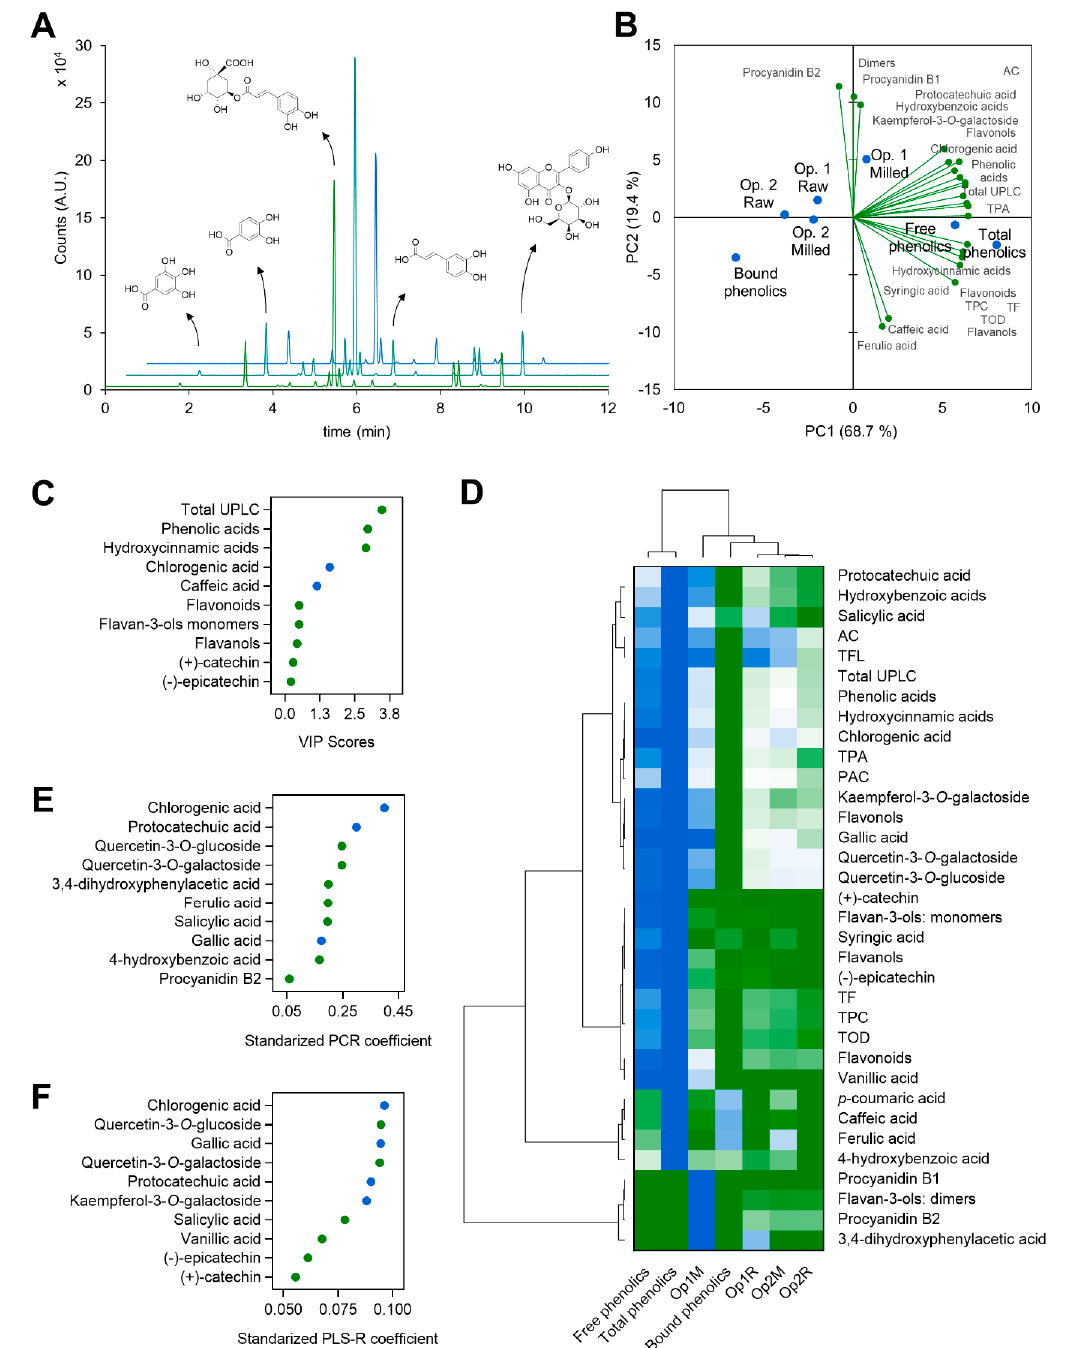
Figure 3. Superimposed chromatograms of the extract at optimal conditions, free, and bound phenolics and the chemical structures of gallic, protocatechuic, chlorogenic, caffeic acids and kaempferol-3- O -galactoside, major phenolic compounds found in the coffee husk ( A ), biplot (scores of samples and load factors of each variable) of the principal component analysis (PCA) ( B ), Variable importance in projection (VIP) scores from partial least squares analysis (PLSA) ( C ), agglomerative hierarchical cluster analysis coupled to heatmap (from the lowest ( ) to the highest ( ) value for each parameter) ( D ) showing the associations among the measured parameters and classifying phenolic extracts from coffee husk according to them, and the ten most significant coefficients from principal components regression, PCR ( E ) and principal least squares regression, PLS-R ( F ). Circles in different colors indicate minor phenolic or phenolic family, green ( ), major phenolic, blue ( ).